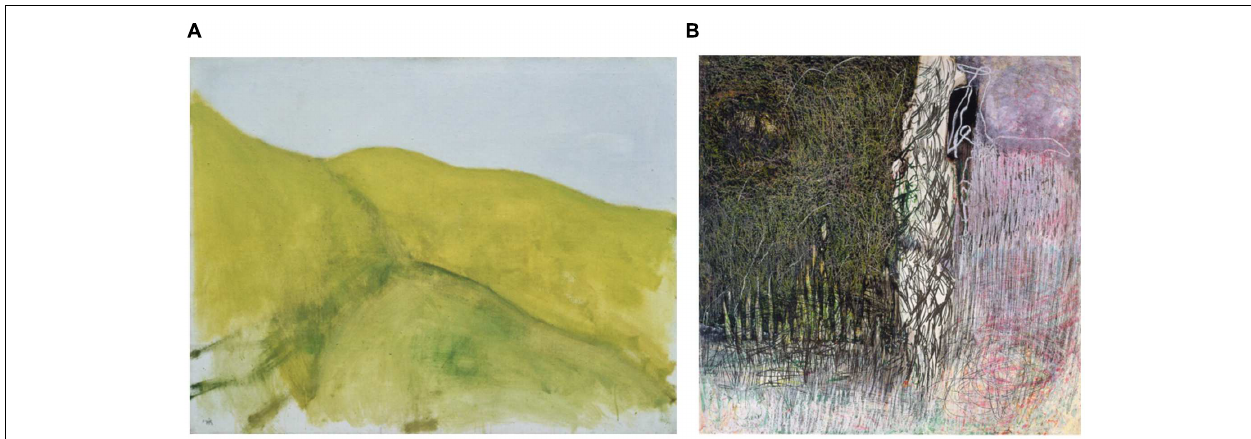
FIGURE 1 | Levels of abstraction in the visual arts. (A) An example of figurative or semi-figurative painting illustrating some of the characteristics of abstraction in art, such as selection (of gross forms only, and using a limited palette of colors), elimination (of pictorial details), amplification (of the forms such as silhouettes and the contours between them), and the analogy between dissimilar entities (the female body and a landscape); in Ori Reisman, Woman-landscape, 1960s, Oil on canvas, 130 cm × 97 cm, courtesy of the Reisman collection, Kibbutz Cabri, Israel. (B) Fully abstract painting, eliminating any figure or object representation, focusing only on the medium as means of expressions of ideas. Zvi Mairovich, Already More Near Than Far, 1966/68, Panda, 100 cm × 100 cm, Courtesy of S. Mairovich.